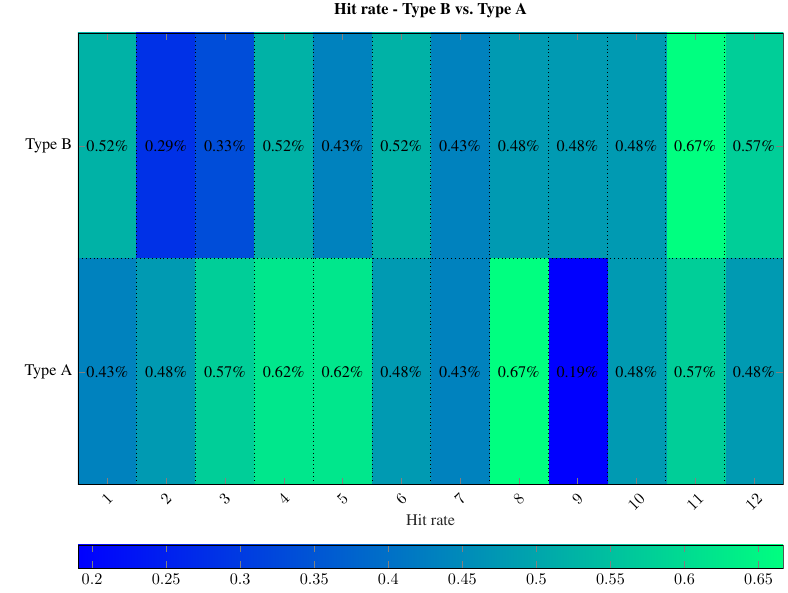
Figure 5. Comparison Hit